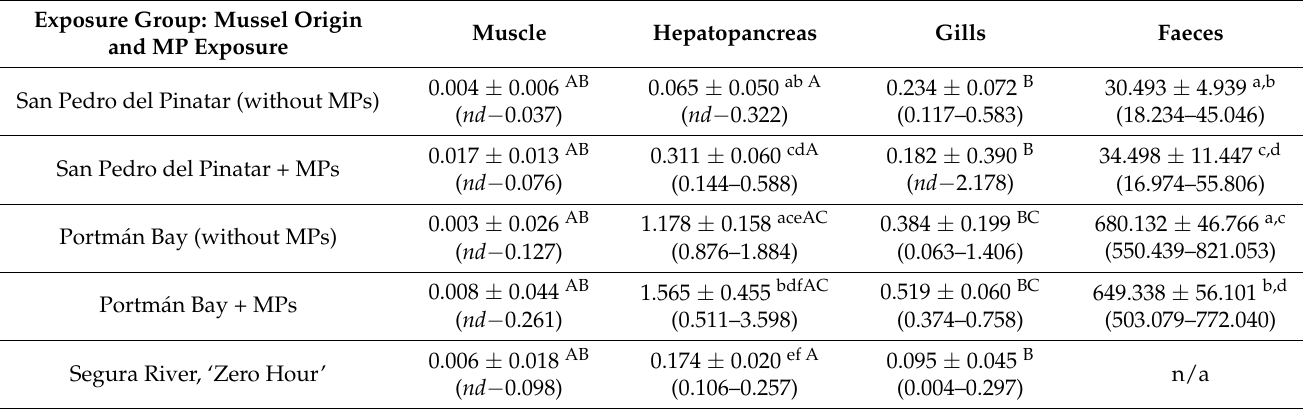
Table 1. Descriptive statistics (geometric mean, standard error, minimum and maximum) of the Pb concentrations in